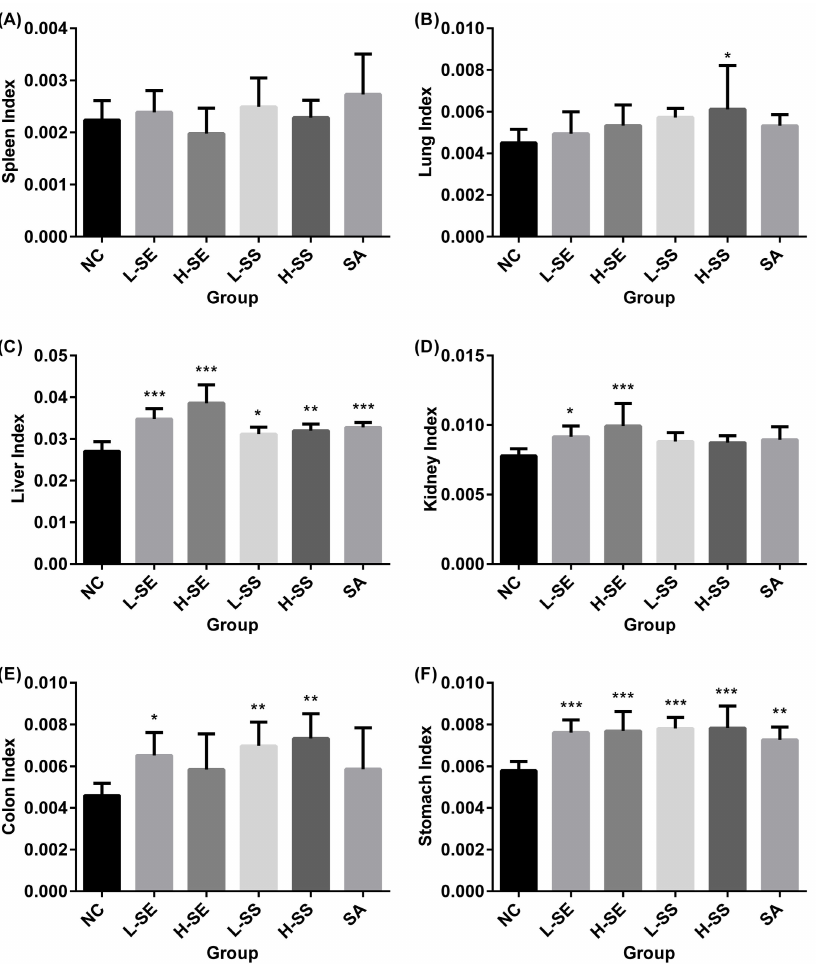
Figure 3. The organ index of normal control (NC) rats and diarrhea rats induced by the low dose of senna extract (L-SE), high dose of senna extract (H-SE), low dose of sennosides (L-SS), and high dose of sennosides (H-SS) and sennoside A (SA) for over 6 days. * represents a significant difference with the p < 0.05, ** represents significant difference with the p < 0.01, and *** represents significant difference with the p < 0.001. ( A ) The spleen index; ( B ) The lung index; ( C ) The liver index; ( D ) The kidney index; ( E ) The colon index; ( F ) The stomach